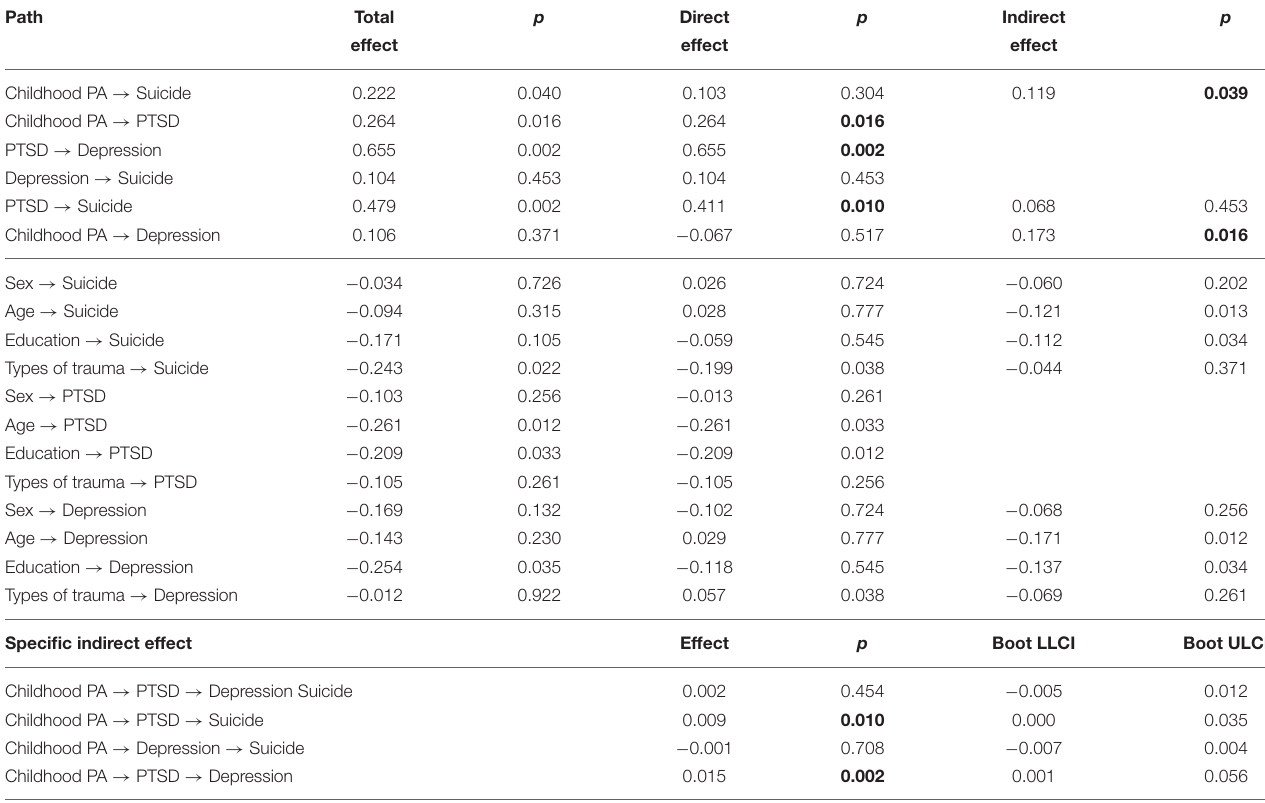
TABLE 2 | Standardized total, direct, indirect, and specific indirect effects of structural model in patients with PTSD ( N = 114). Path Total p